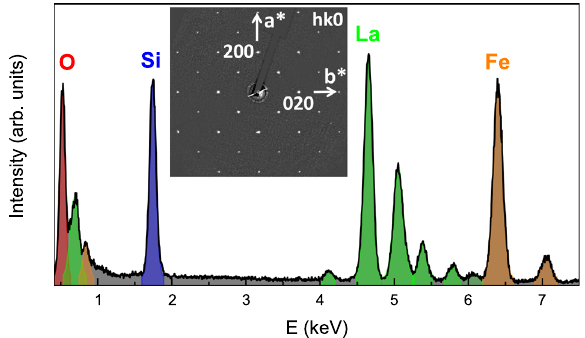
Fig. 1 Elemental composition and crystal structure from TEM. EDX spectrum recorded on one crystallite showing an oxygen peak at 0.525 keV in the LaFeSi matrix. Inset: hk0-cut of the reciprocal space indexed in P4/nmm space group of LaFeSiO 1 − δ .